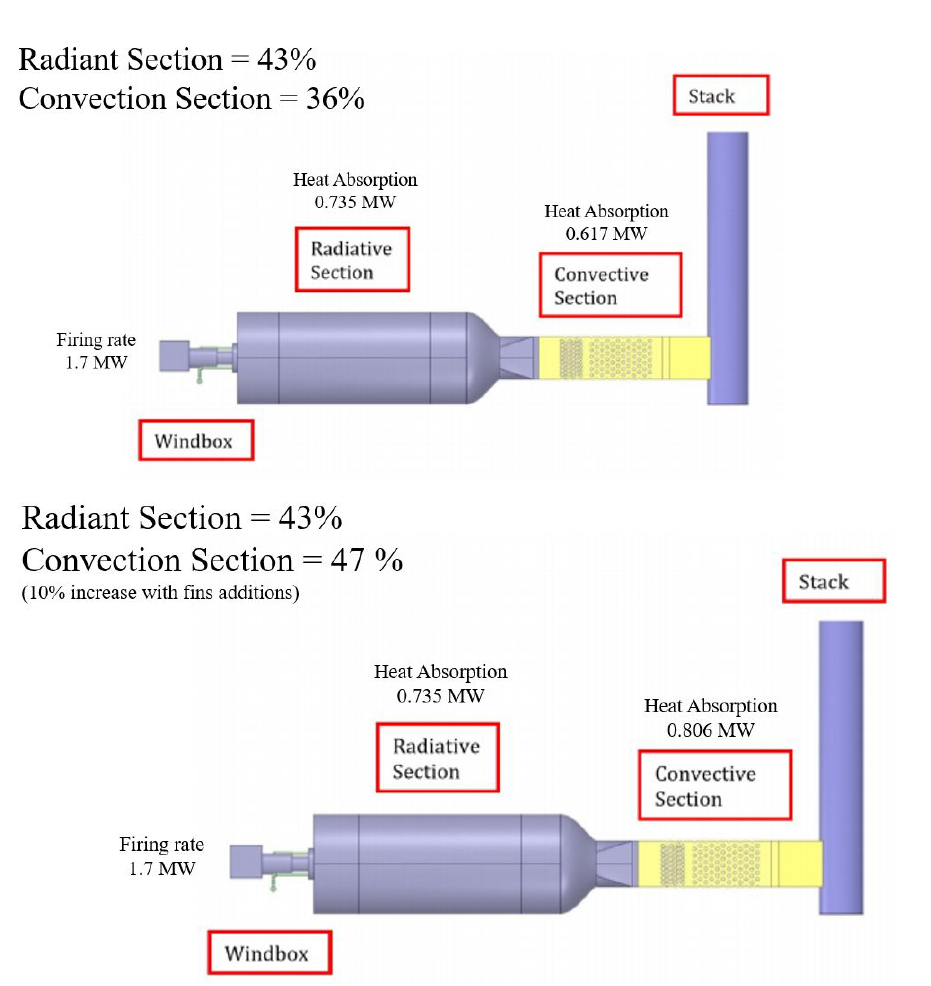
Figure 17. Duty distribution within OTSG